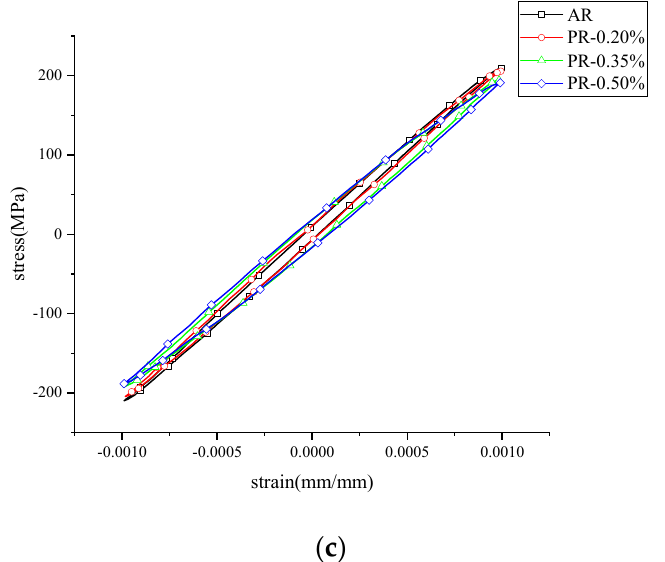
Figure 6. Half − cycle stressstrain response at different strain levels. ( a ) 0.2% strain amplitude; ( b ) 0.15% strain amplitude; ( c ) 0.1% strain amplitude.